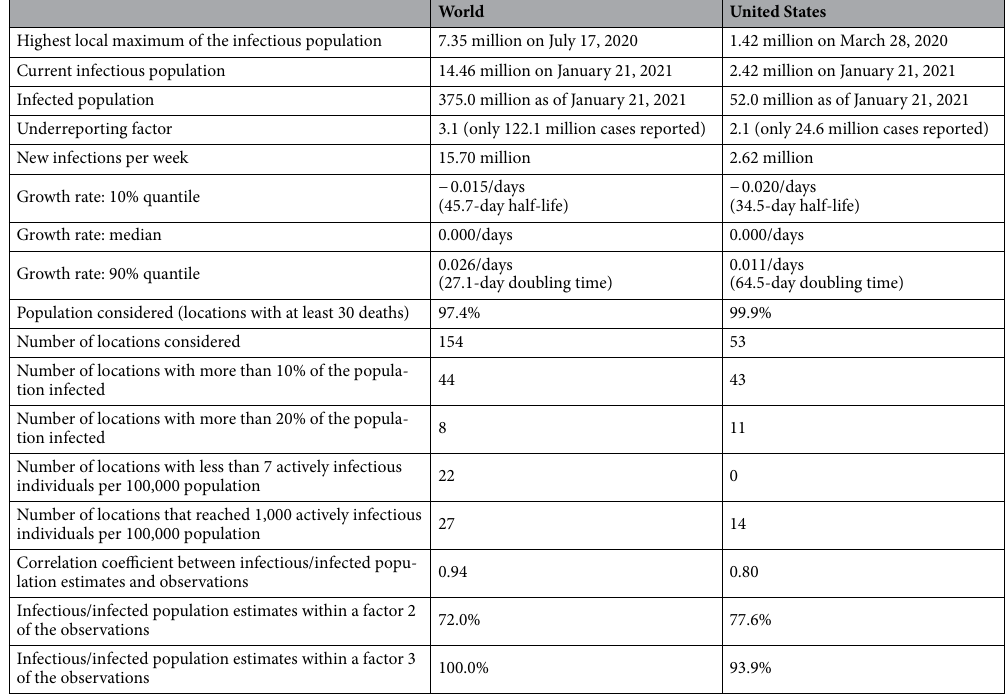
Table 1. Key estimates of the